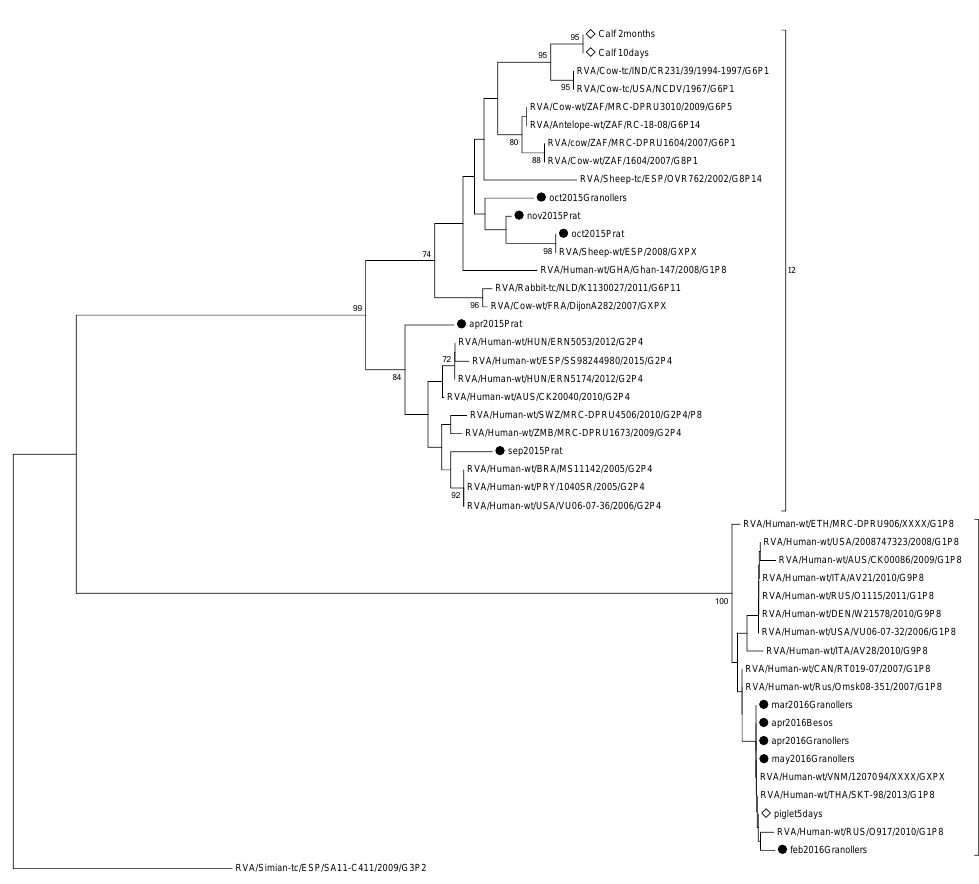
Figure 3. Phylogenetic analysis of the rotavirus A (RVA) VP6 gene from raw sewage and animal samples. The raw sewage samples from the present study are indicated with a black dot followed by month, year and wastewater treatment plant of collection. Samples recovered from animals are indicated with white diamonds.